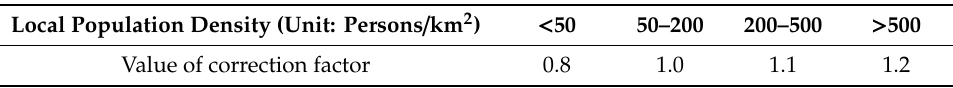
Table 10. Value of the density correction factor of the estimated indoor population density